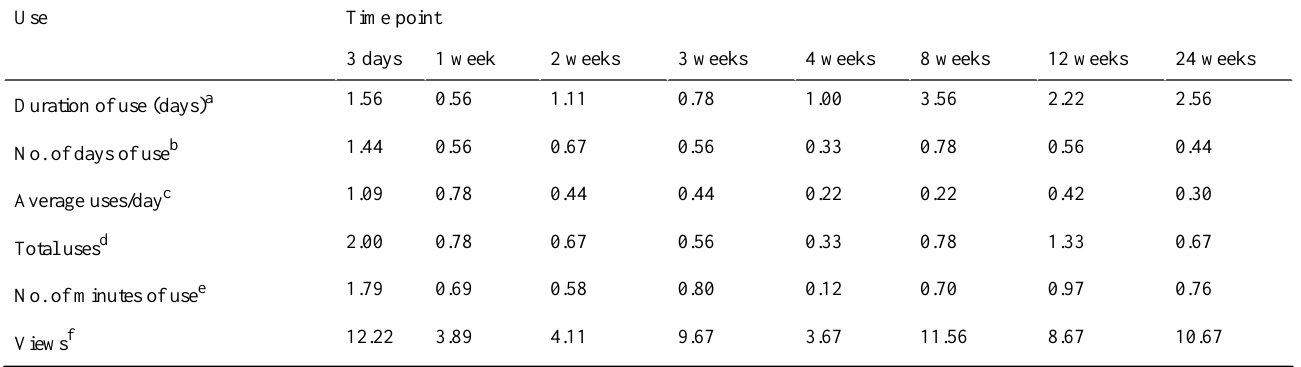
Table 3. Average frequencies of use during the period measured at each time point.